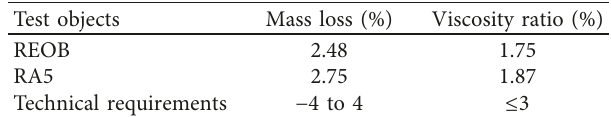
Figure 2: The rotary accelerated loading test (RALT) system. (a) Front view of the RALT, (b) console, and (c) temperature control system. Table 3: Ageing indexes of REOB and RA5 after a 5 h TFOT.